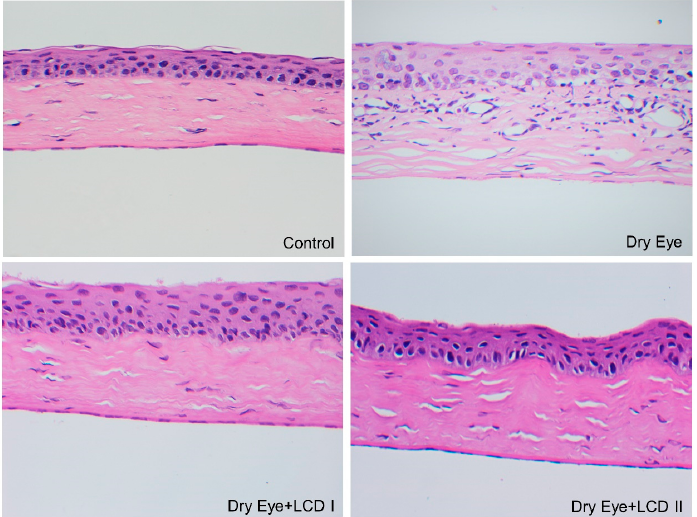
Figure 7. Effect of the combination of lutein/zeaxanthin, curcumin and vit D (LCD) on histopathological changes in benzalkonium chloride (BAC)-induced dry eye syndrome in rats. Control: No treatment; Dry Eye: BAC-induced dry eye syndrome; LCD I; Dry Eye + LCD I: BAC- induced dry eye syndrome plus LCD I (100 mg/kg body weight); Dry Eye + LCD II: BAC-induced dry eye syndrome plus LCD II (200 mg/kg body weight). Control: A histological appearance of a normal cornea. Dry Eye: The increased thickness of the corneal epithelium, inflammatory cell infiltration, and edema under the epithelium. Dry Eye + LCD I: Mild epithelial thickness, mild edema under the epithelium, and disappearance in infiltration. Dry Eye + LCD II: Normal appearance in epithelium thickness and